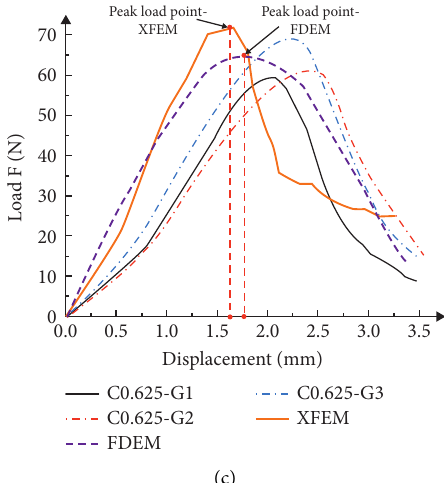
Figure 19: Load-displacement curves of simulation and physical test. (a) C ˆ 0; (b) C ˆ 0.375; (c) C ˆ 0.625.